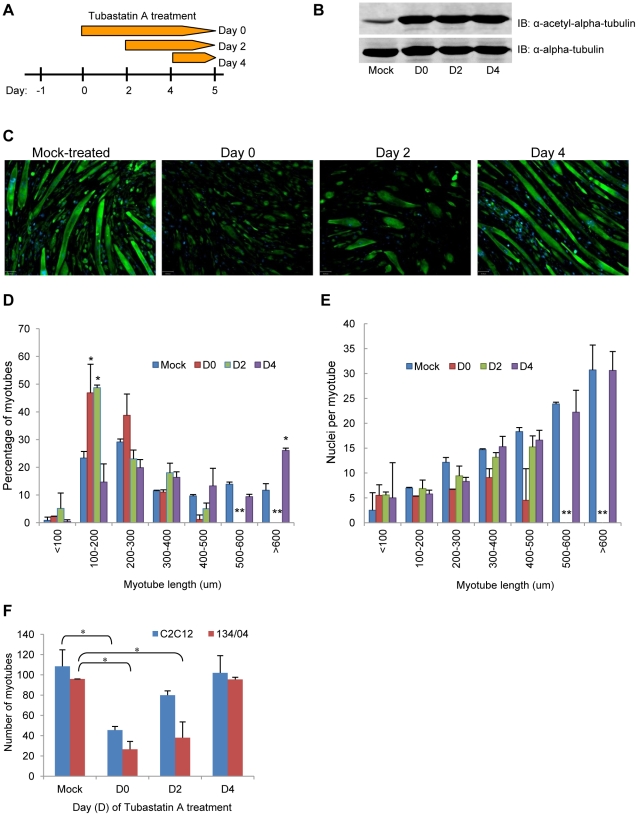
Effect of HDAC6 inhibition on myotube formation.(A) C2C12 or 134/04 myoblasts were seeded in growth media on Day -1, then switched to differentiation media on Day 0. Cells were mock-treated (Mock) or treated with 7.5 µM Tubastatin A beginning on different days post-induction of myogenic differentiation (Day 0, Day 2, Day 4). On Day 5, cells were fixed and stained with an anti-desmin antibody and DAPI. (B) Alpha-tubulin acetylation levels were assayed to confirm Tubastatin A efficacy. (C) Representative immunofluorescence images of desmin-stained myotubes in each treatment regime. Scale bar: 60 µm. (D) Desmin-stained myotubes were categorized by their myotube length, and plotted against their relative number. (E) Desmin-stained myotubes were counted for their average number of nuclei and categorized by myotube length as in (D). * in (D) and (E) indicates p<0.05, significantly different from mock-treated myotubes in the same category. ** indicates that no myotubes were observed in the indicated category. (F) Absolute number of desmin-stained myotubes were counted and categorized by treatment regime. * indicates p<0.05, significantly different from Mock-treated. Shown here are results for C2C12 cells; similar results were obtained for 134/04 cells (not shown).